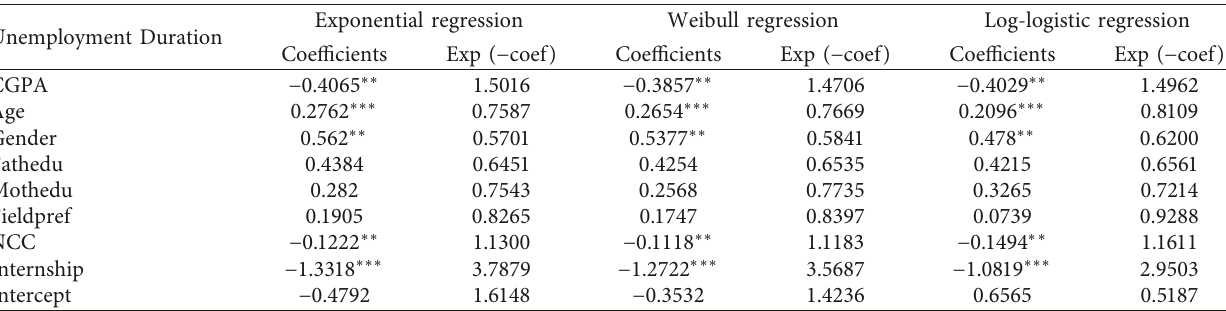
Table 10: Parametric regression model hazards and